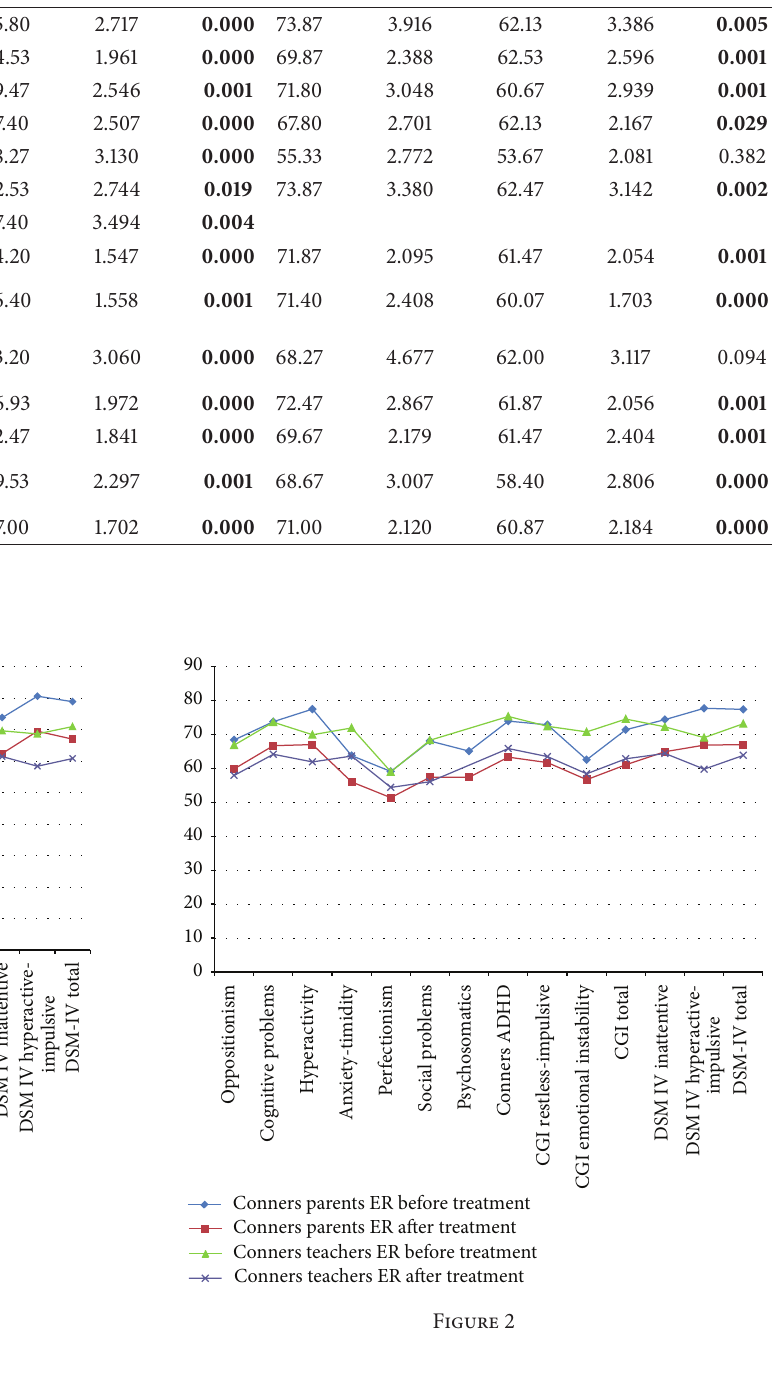
When comparing the IR versus ER groups in parent’s Conners scales, significant differences were found before treatment in CGI perfectionism and emotional instability, which cease to exist after treatment (Table 4). For teachers no